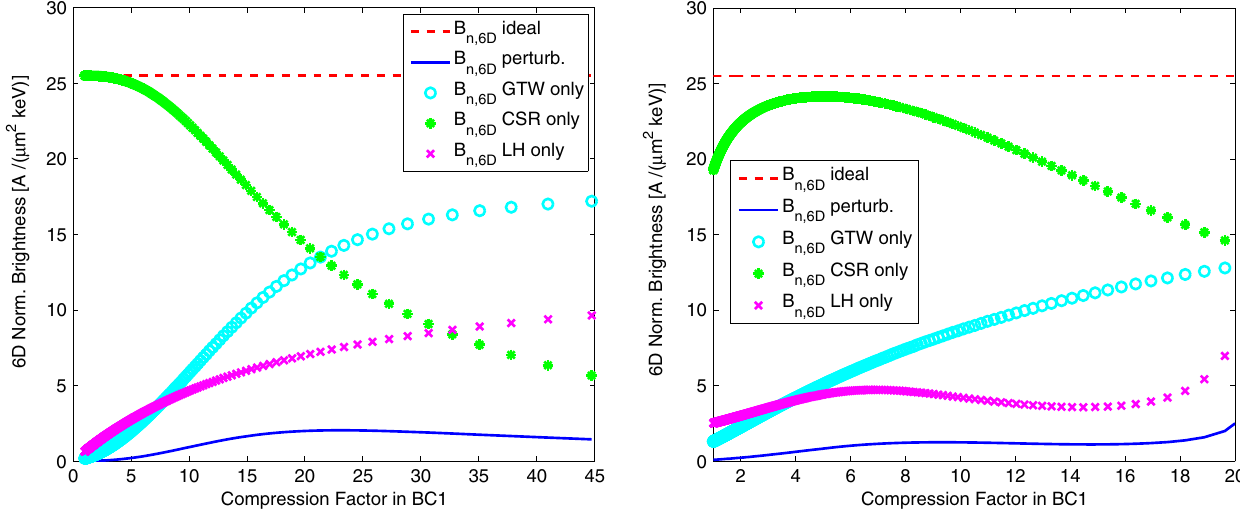
FIG. 6. Analytical estimate of B at the end of SL (see Fig. 3) for the one-stage (left) and two-stage compression, as a function of the n; 6 D compression factor in BC 1 . In the two-stage, the total compression factor is fixed to